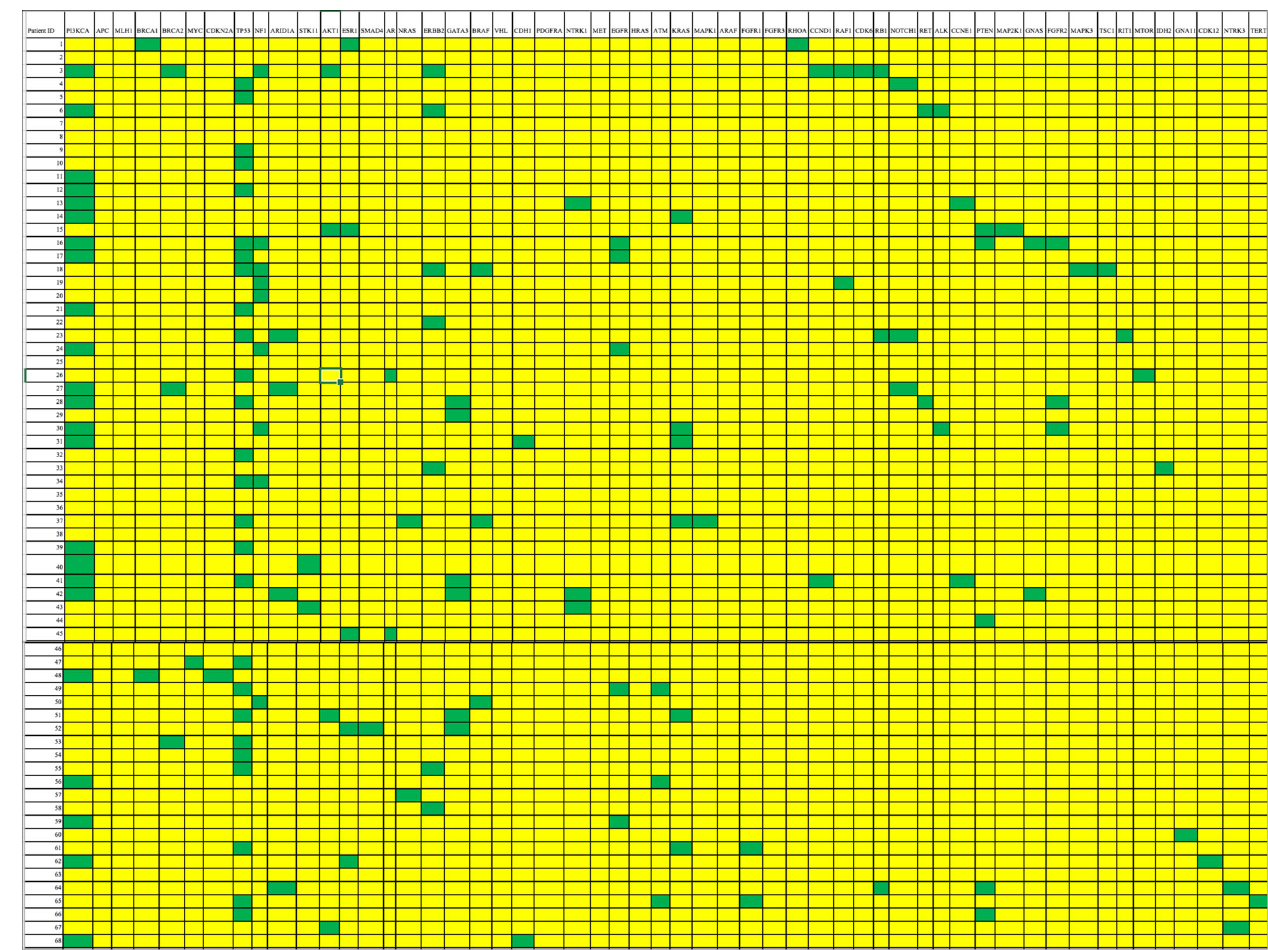
Fig. 4 Cell-free DNA mutation spectrum in individual patients with non-BM. Differences in the mutation spectrum were seen between BM and